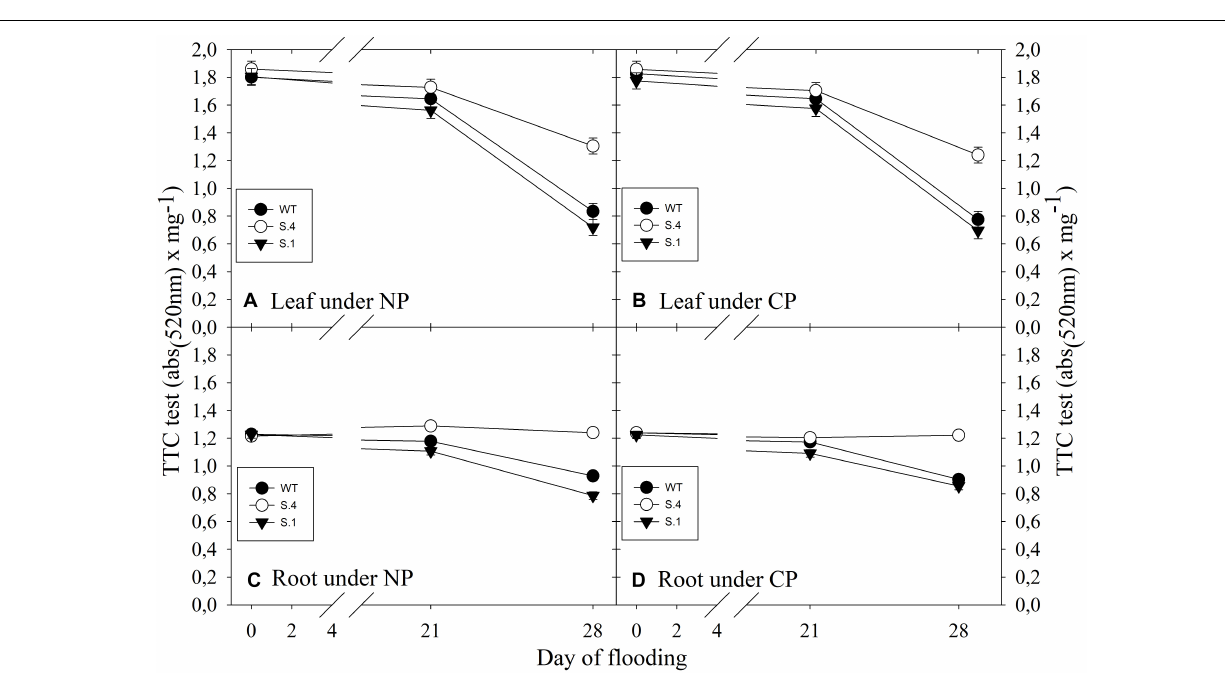
FIGURE 6 | Respiratory activity (as TTC reactivity) detected in the leaf (A,B) and in the root (C,D) during flooding trials. Symbols represent the average of five biological replicate samples and bars represent ± SD. In the case of very low value of SD the bar is covered by the